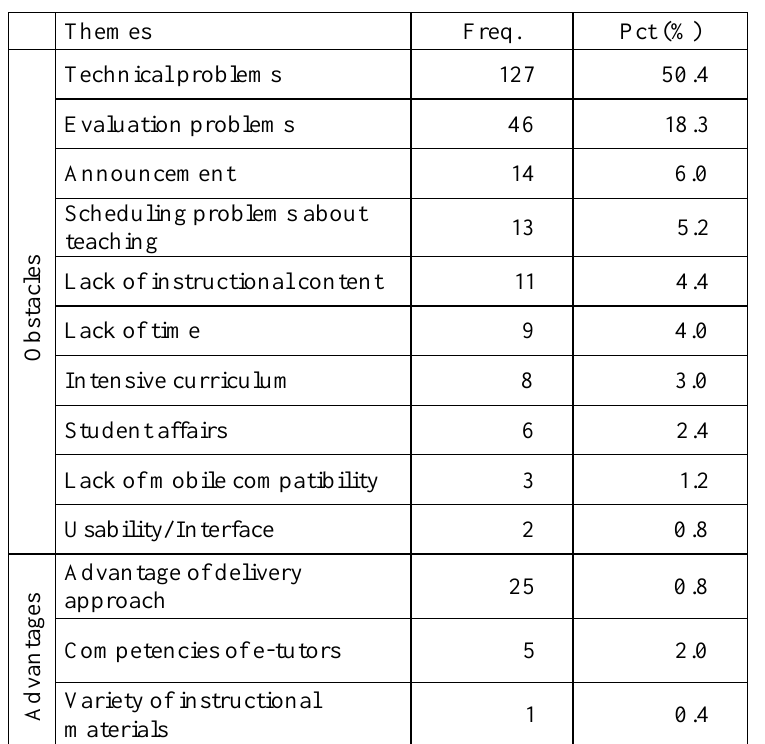
Emerging Themes for